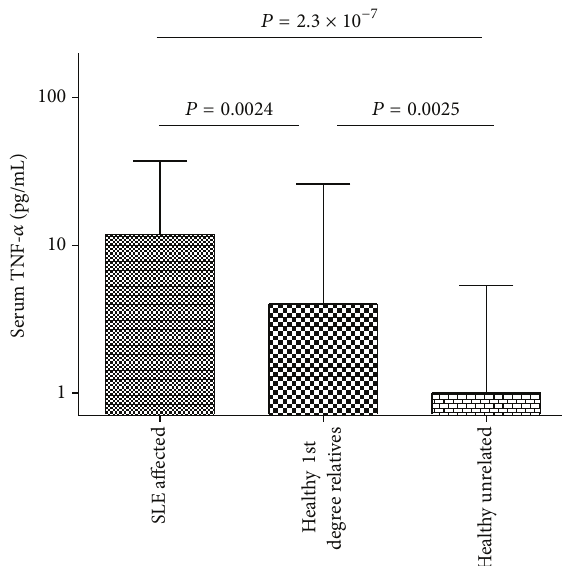
Figure 1: Serum TNF- 𝛼 levels in SLE patients, first degree relatives, and unrelated controls. Bars show the median; error bars show the interquartile range, 𝑃 values by Mann-Whitney 𝑈